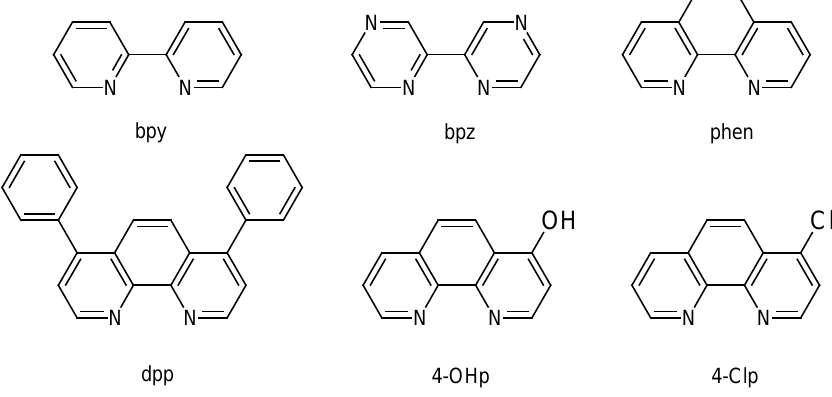
Figure 2. Chemical structure of the chelating ligands used in this work.